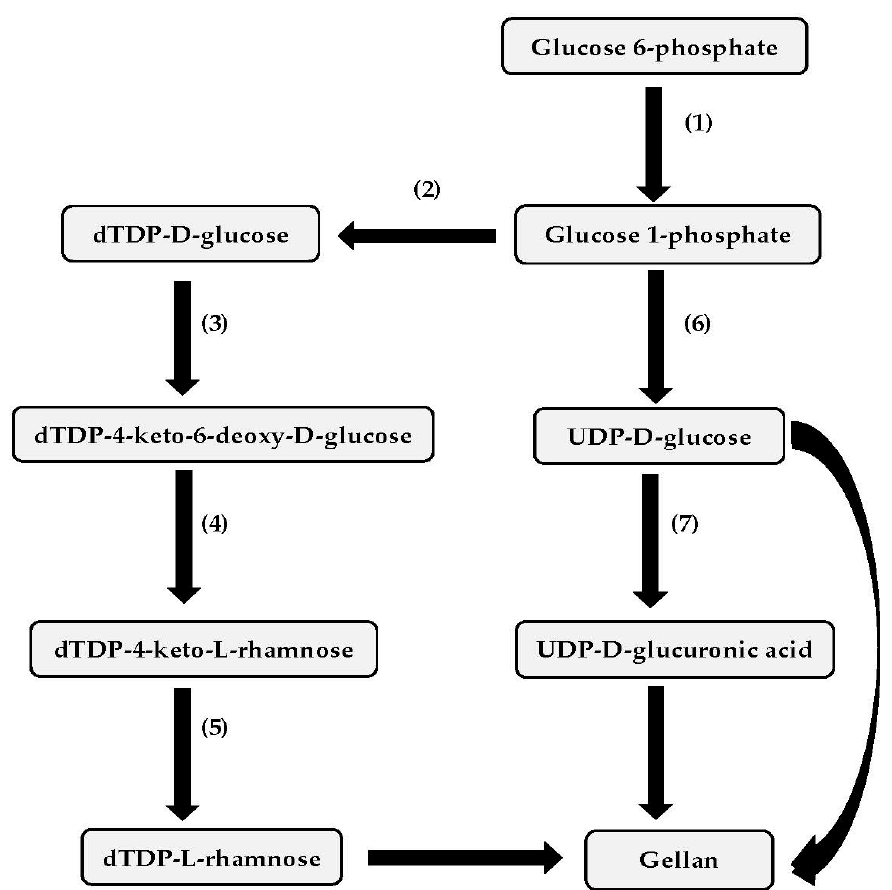
Figure 2. The metabolic pathways in Sphingomonas elodea thought to be involved in gellan synthe- sis [54–59]. The pathway enzymes involved include ( 1 ) phosphoglucomutase; ( 2 ) dTDP- D -glucose pyrophosphorylase; ( 3 ) dTDP- D -glucose 4,6-dehydratase; ( 4 ) dTDP-4-dehydrorhamnose 3,5 epimerase; ( 5 ) dTDP-4-dehydrorhamnose reductase; ( 6 ) glucose-1-phosphate uridyltransferase; ( 7 ) UDP- D -glucose dehydrogenase. Abbreviations: UDP, uridine diphosphate; dTDP, thymidine di- phosphate.